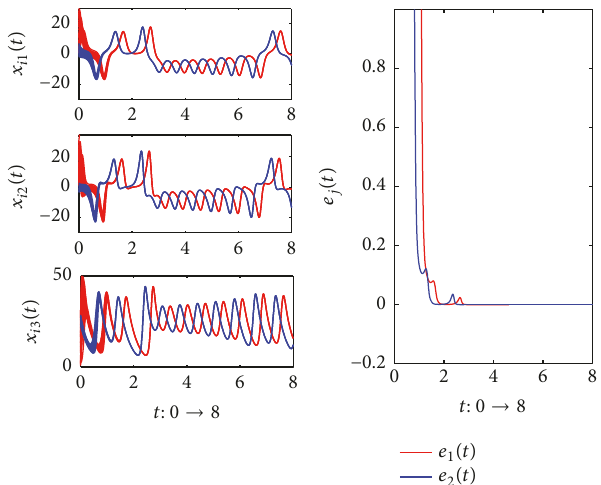
Figure 5: Time evolutions of the 𝑥 ⋅2 -coupled Lorenz systems 𝑥 𝑖1 (𝑡) , 𝑥 (𝑡) , 𝑥 (𝑡) (𝑖 = 1, 2,. .. , 100) in the network (2)–(7) with the 𝑖2 𝑖3 controller